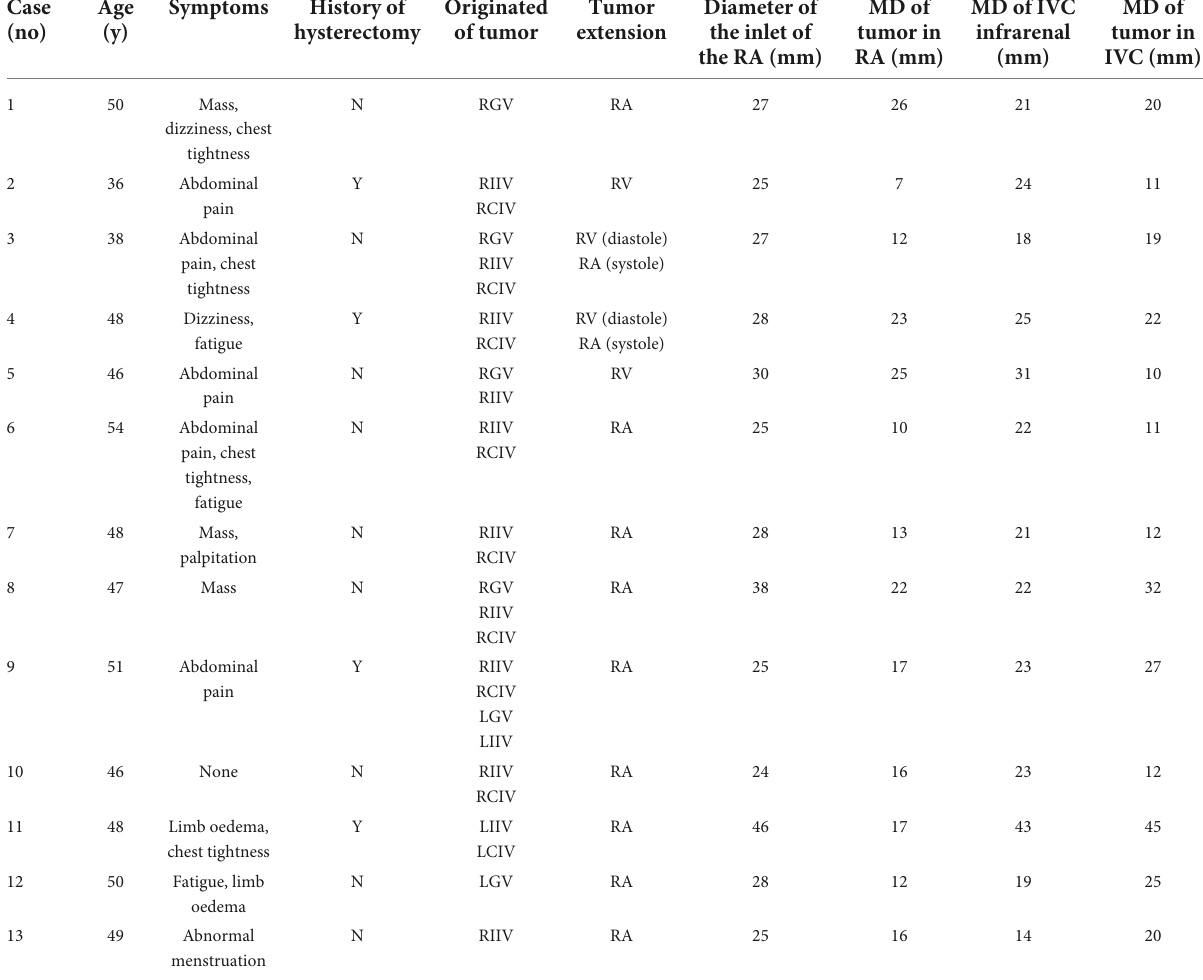
TABLE 1 Patient characteristics and preoperative